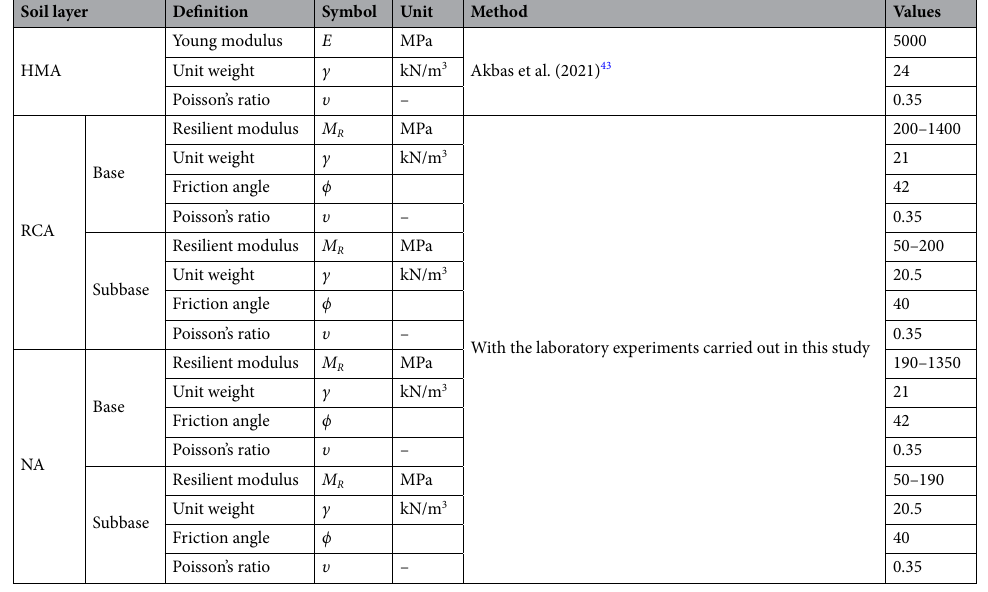
Table 5. HMA, RCA and NA parameters used in the analysis.